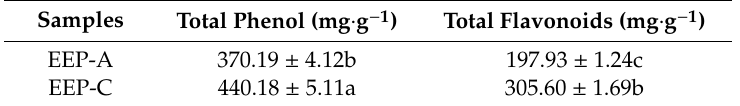
Table 1. Total phenol and flavonoid contents of propolis and bud poplar